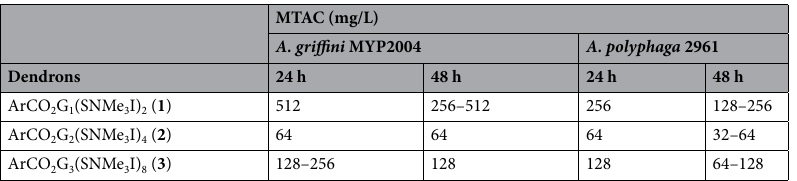
Table 1. MTAC (mg/L) values in A. griffini MYP2004 and A. polyphaga 2961 after 24 and 48 h of dendron treatment. ArCO